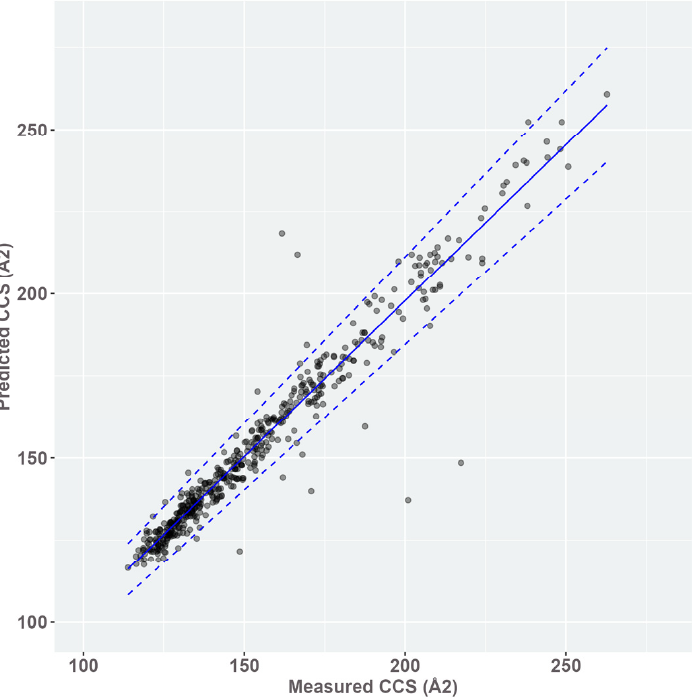
Figure 4. Predicted CCS (Å 2 ) using CCSBase algorithm [29] by measured CCS (Å 2 ). Validation was performed on the CCS of 501 adducts from 297 standard compounds measured in ESI − and ESI+. Linear regression: adjusted R 2 = 0.938. Blue line: best fit of linear regression. Dashed blue lines best fit +/ − 6.72% (2 SD). Predicted CCS = 0.95 × measured CCS + 7.92. 3.3. Rt Prediction and Creation of an Rt Database The Rt prediction workflow is described in Figure 5. In total, 204 compounds from the developed method were selected for the QSRR model; 114 were detected in both ESI+